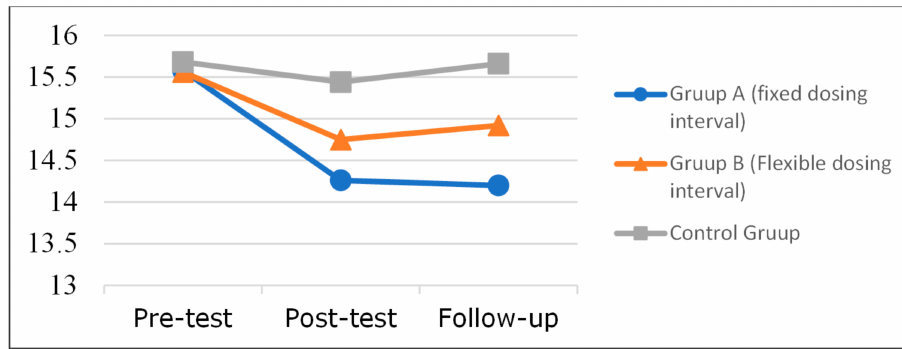
Figure 2. CES-D means by group at time 1 (pre), time 2 (post), and time 3 (follow-up). Table 2. Summary of ANCOVA Results of Post-test. Source